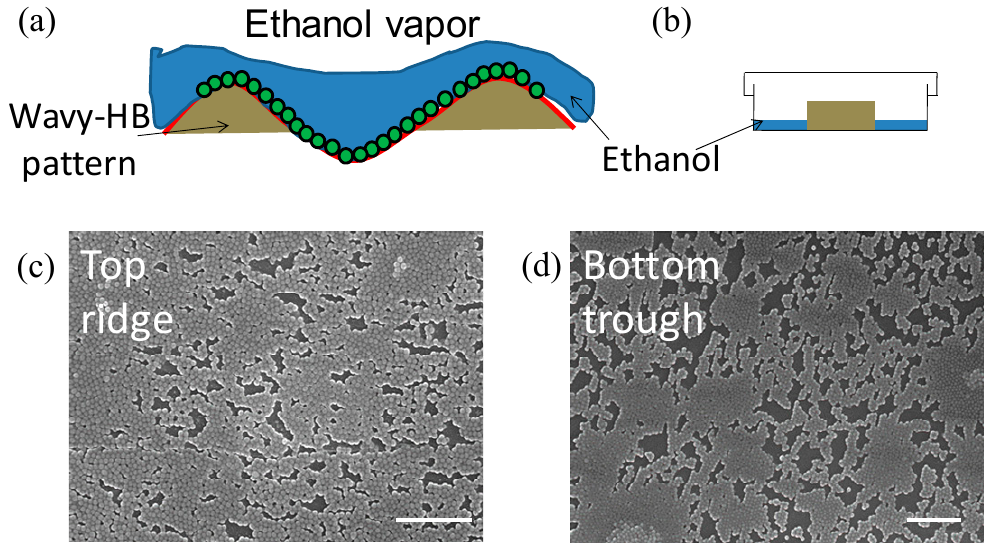
Figure 3. ( a ) Illustrative image of the NP deposition under the ( b ) improved evaporation setting. Scanning electron microscopy (SEM) images of deposited NPs on the ( c ) ridge and ( d ) in the trough after the deposition process. Scale bar: 2 μ m.